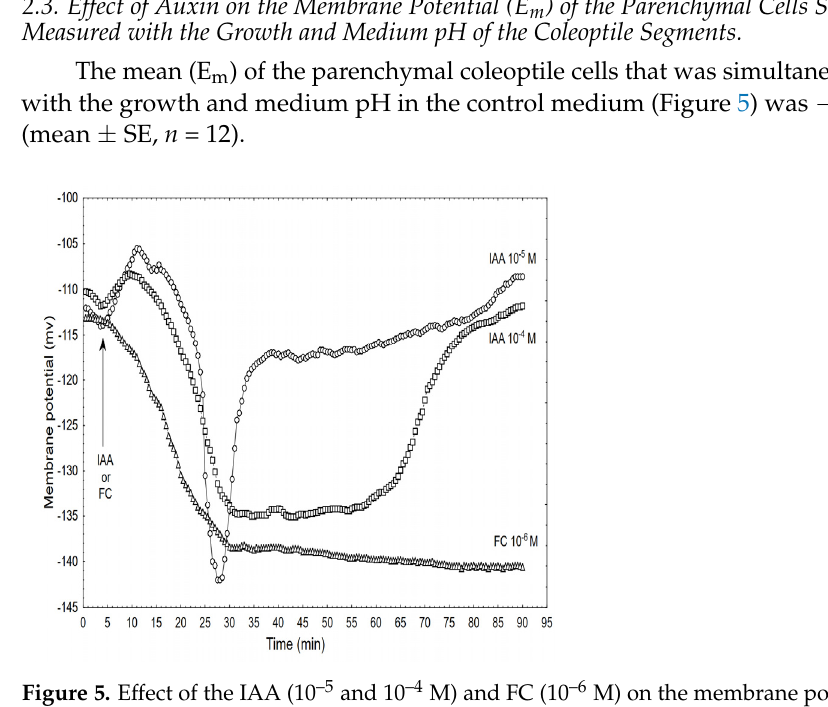
Figure 5. Effect of the IAA (10 –5 and 10 –4 M) and FC (10 –6 M) on the membrane potential (E m ) of the parenchymal coleoptile cells simultaneously measured with the growth and medium pH. At 5 min (arrow), the IAA or FC was added to the growth medium. The typical results that were selected from at least seven experiments is presented. The adequate mean values are indicated in the text.